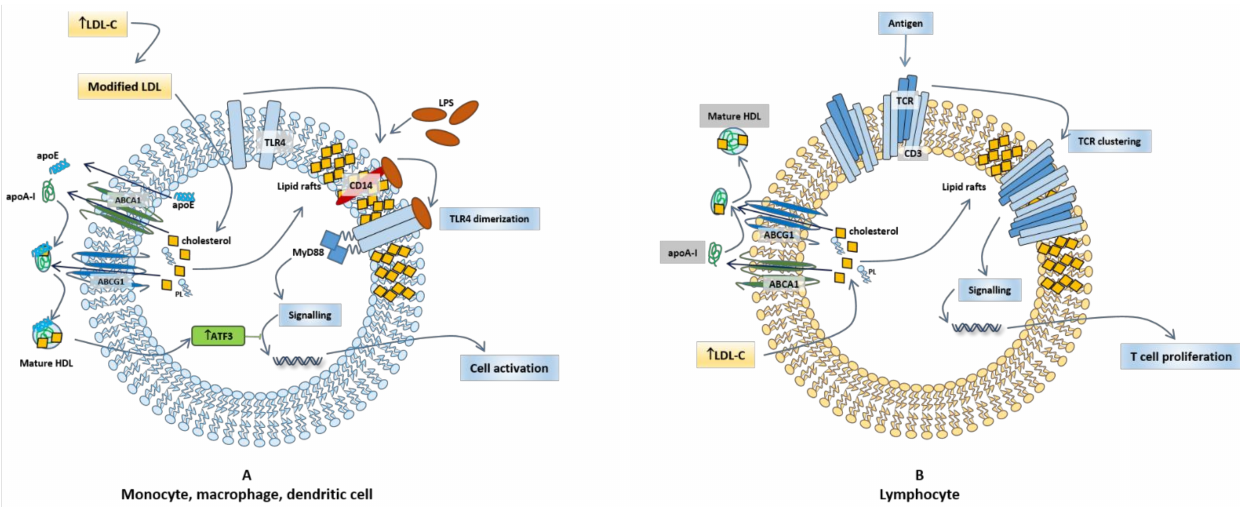
Figure 1. Role of cholesterol efflux in innate immune cell activation. ( A ) TLR4, which is expressed in innate immune cells including monocytes, macrophages and dendritic cells, is activated by lipopolysaccharide (LPS). These cells express also high amounts of CD14, which facilitates the activation of TLR4 by LPS. LPS induces a transient TLR4 trafficking to lipid rafts; following dimerization, a process required for the initiation of signaling during innate immune response, TLR4 triggers the MyD88-dependent signaling pathway, leading to the production of pro-inflammatory cytokines and cell activation. ApoA-I and HDL, as well as apoE, may dampen inflammation by selectively reducing the free cholesterol content in lipid rafts and the consequent chance of an MyD88-dependent TLR trafficking to lipid rafts in cells exposed to LPS. PL: phospholipids. ( B ) In resting T-cells, TCR is localized in non-raft domains of plasma membrane in monomeric form. Cholesterol is imported into the cell LDL; when TCRs become antigen stimulated, they associate with lipid rafts, thus resulting in the activation of downstream signaling pathways and consequent T cell proliferation. ApoA-I and HDL, by removing cholesterol from cell membrane, may modulate the abundance of lipid rafts and their content of cholesterol, thus controlling T cell immune